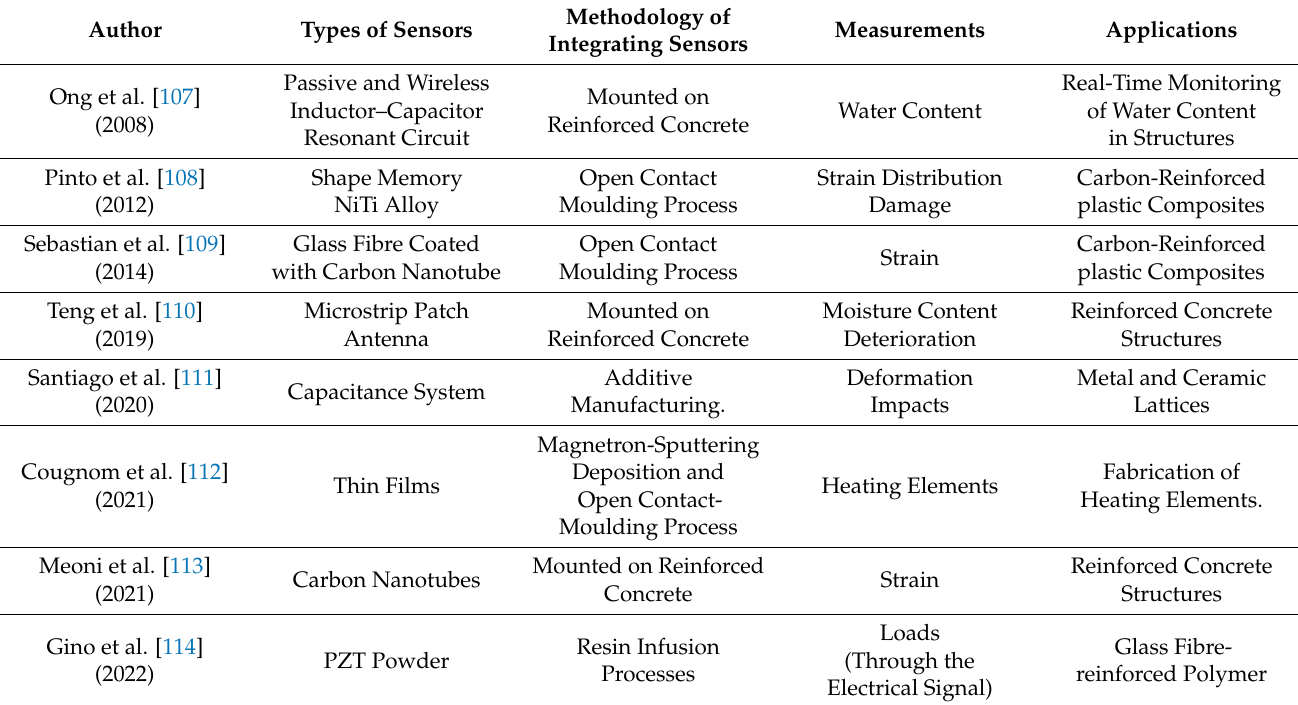
Table 8. Overview of applications, type of embedded sensors used, and methodology of integrating sensors for composite structural